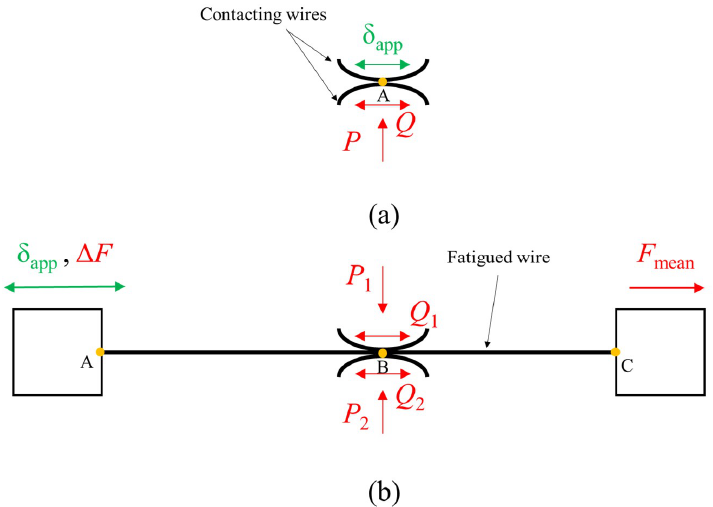
Figure 2. Schematic of the performed tests: ( a ) fretting wear; ( b ) combined fretting wear and fretting fatigue, where P is the normal load, Q is the tangential load, δ app and ∆ F are the reciprocating displacement and the applied force range respectively and F mean is the mean force.